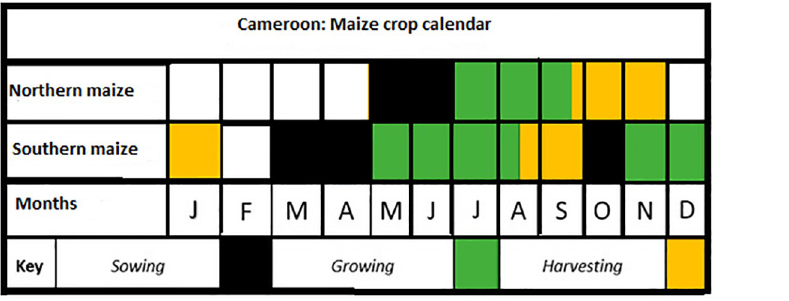
Fig 3. Maize crop calendar for Cameroon. Source: Authors’ conceptualization.